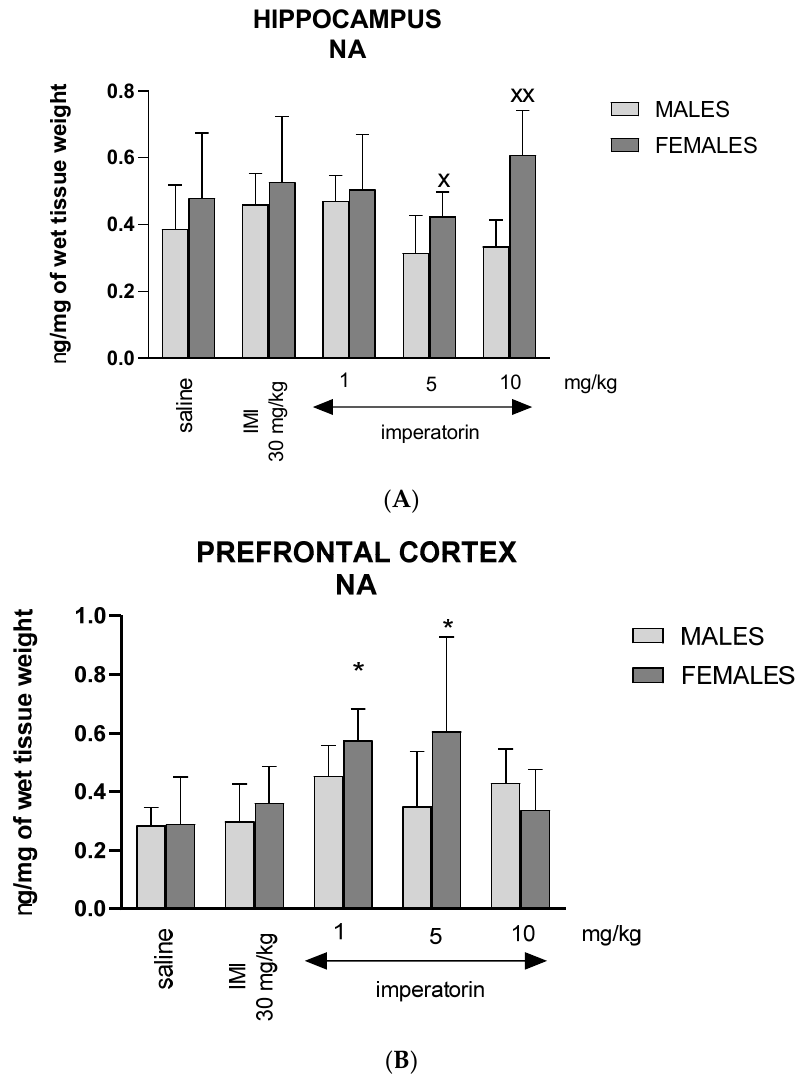
Figure 6. The level of NA (ng/mg) in the ( A ) hippocampus and ( B ) prefrontal cortex after impera- torin injection (1, 5, and 10 mg/kg). n = 8–10; mean ± SD; * p < 0.05, vs. saline-treated control group, X p < 0.05, XX p < 0.01 vs. male group; Bonferroni’s